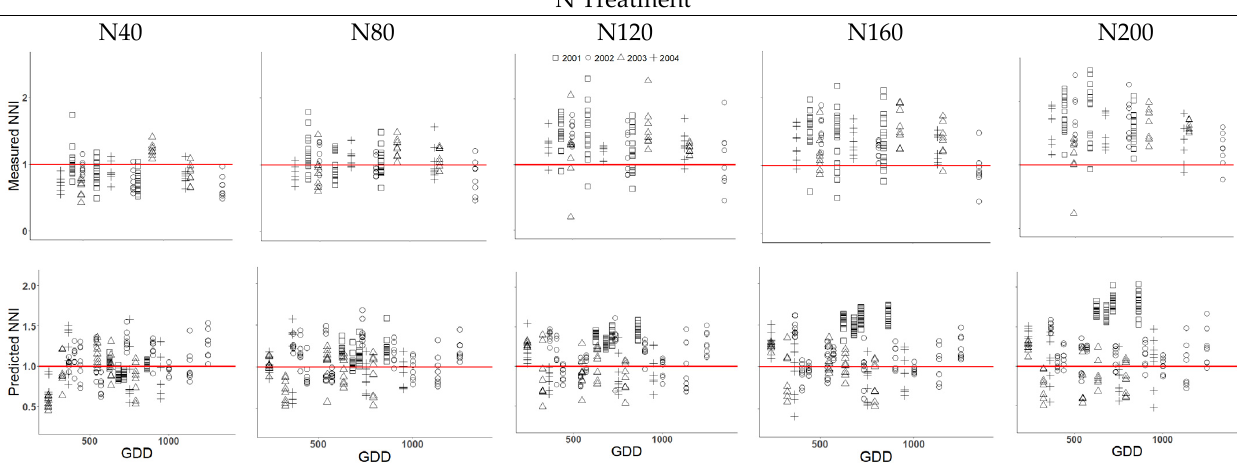
Figure 4. Measured and predicted NNI for 2001, 2002, 2003, 2004 per GDD for each N treatment. A red horizontal line is drawn at NNI = 1.